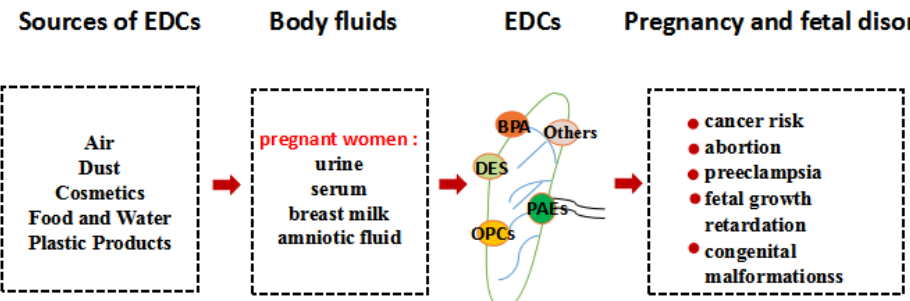
Figure 1. The transfer routes of several endocrine disrupting chemicals (EDCs) and the damages to pregnant women and fetuses. Pregnant women are exposed to EDCs from the air, food, and products which damage the placenta through body fluids, thereby causing health problems.